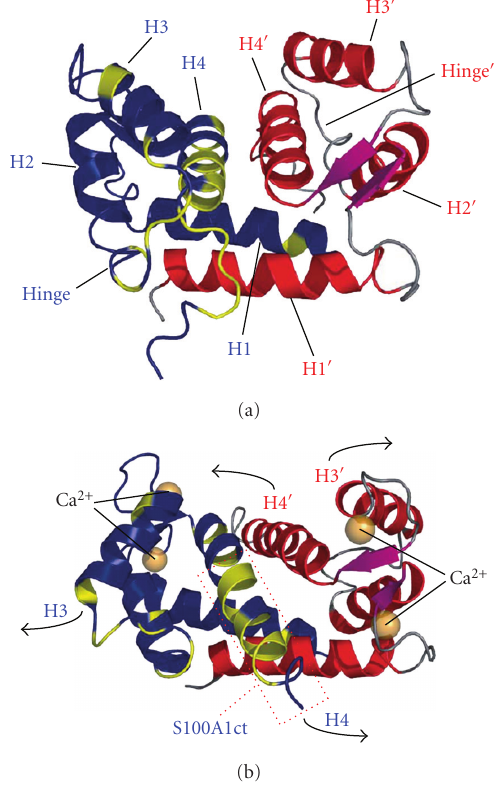
Figure 2: The three-dimensional structure of S100A1 as deter- mined by NMR spectroscopy. (a) S100A1 in the apo state: S100A1 is composed of two identical subunits connected by a linker region (hinge region). Dimerization occurs in an antiparallel manner. (b) S100A1 in the Ca 2+ bound state: Ca 2+ binding to both the N- and C-terminal motif results in an altered orientation of H3/4 and the hinge region uncovering hydrophobic residues for the interaction with target molecules. S100A1 residues 75–94 are indicated by the red box. Reproduced with modifications from Wright et al.